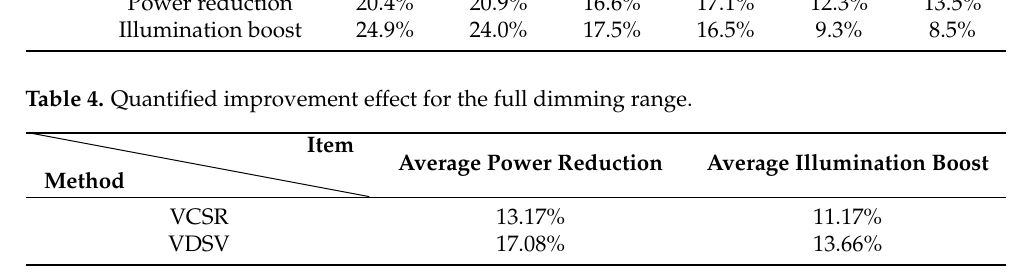
Table 3. Quantified improvement effect of each dimming level obtained by the VDSV Method. Item